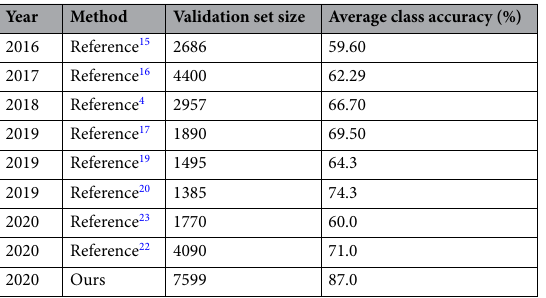
Table 4. Comparison with state-of-the-art DL-based methods for KOA severity assessment